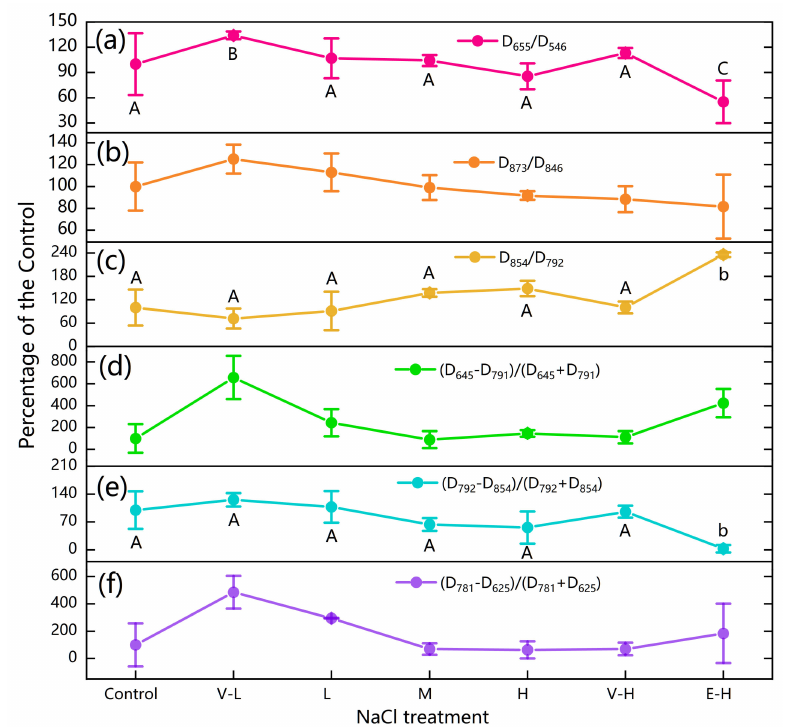
Figure 7. Changes in the sensitive vegetation indices D 655 / D 546 ( a ), D 873 / D 846 ( b ), D 854 / D 792 ( c ), (D 645 / (D + D / (D + D / (D + D − D − D − D 791 ) 645 791 ) ( d ), (D 792 854 ) 792 854 ) ( e ) and (D 781 625 ) 781 625 ) ( f ) of Suaeda salsa under di ff erent NaCl treatments. The control group was set to 100%, and the remaining six groups were changed relative to the control. The values were means ± standard errors (n = 3). Capital and lower-case letters above the bars indicate significant di ff erences at the levels of 0.05 and 0.01. If no letter is assigned above the bars, it means that this item was not significant to salt treatments ( p > 0.05). The real values are presented in Table 5. Other descriptions are as in Figure